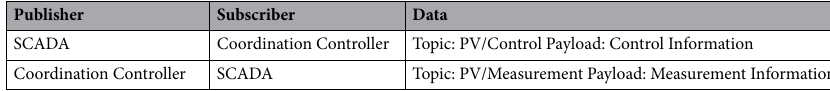
Table 2. SCADA and DER communications using publisher-subscribe model